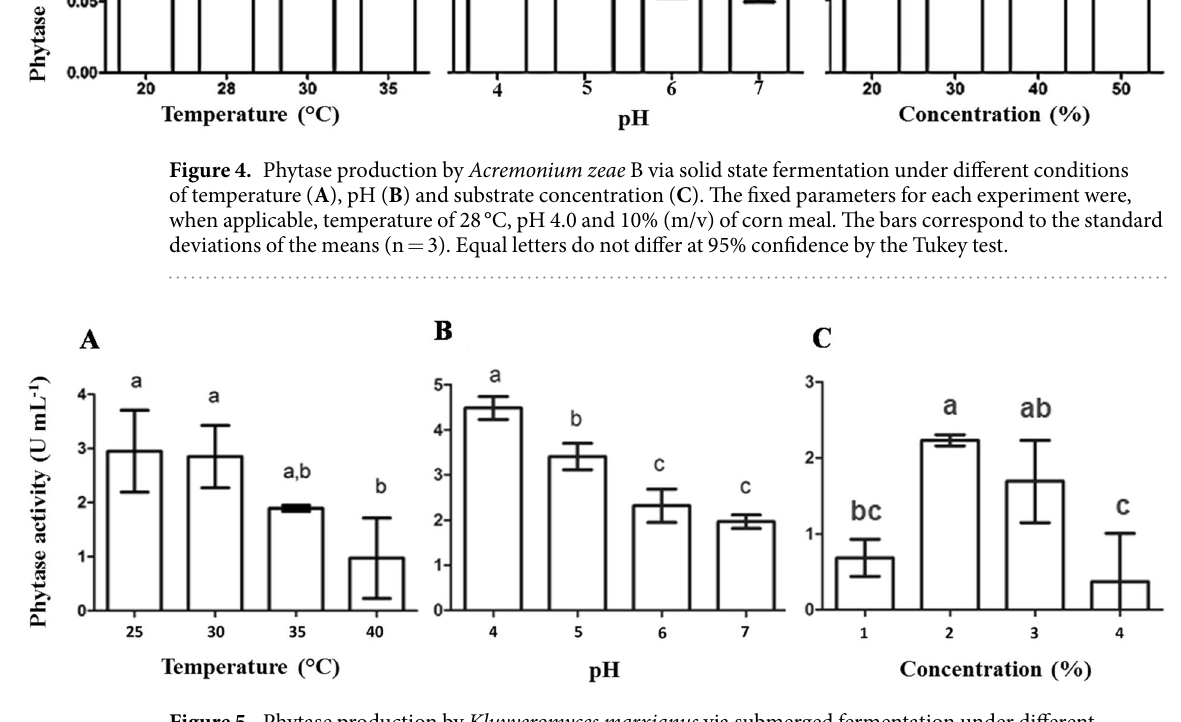
Figure 5. Phytase production by Kluyveromyces marxianus via submerged fermentation under different conditions of temperature, pH ( B ) and substrate concentration ( C ). The fixed parameters for each experiment were, when applicable, temperature of 28 °C, pH 5.8 and 1% (m/v) of rice brain. The bars correspond to the standard deviations of the means (n = 3). Equal letters do not differ.